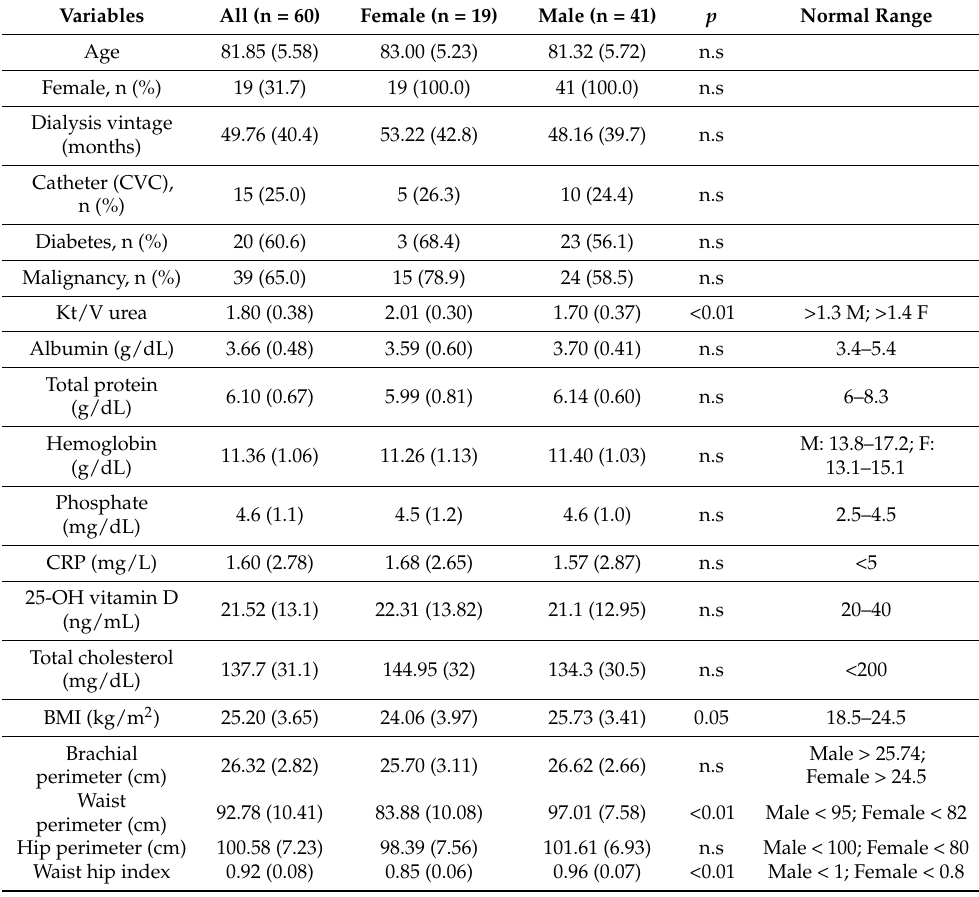
Table 1. Descriptive analysis of the main clinical and analytical variables. p values refer to the comparison between males and females. Mean ±